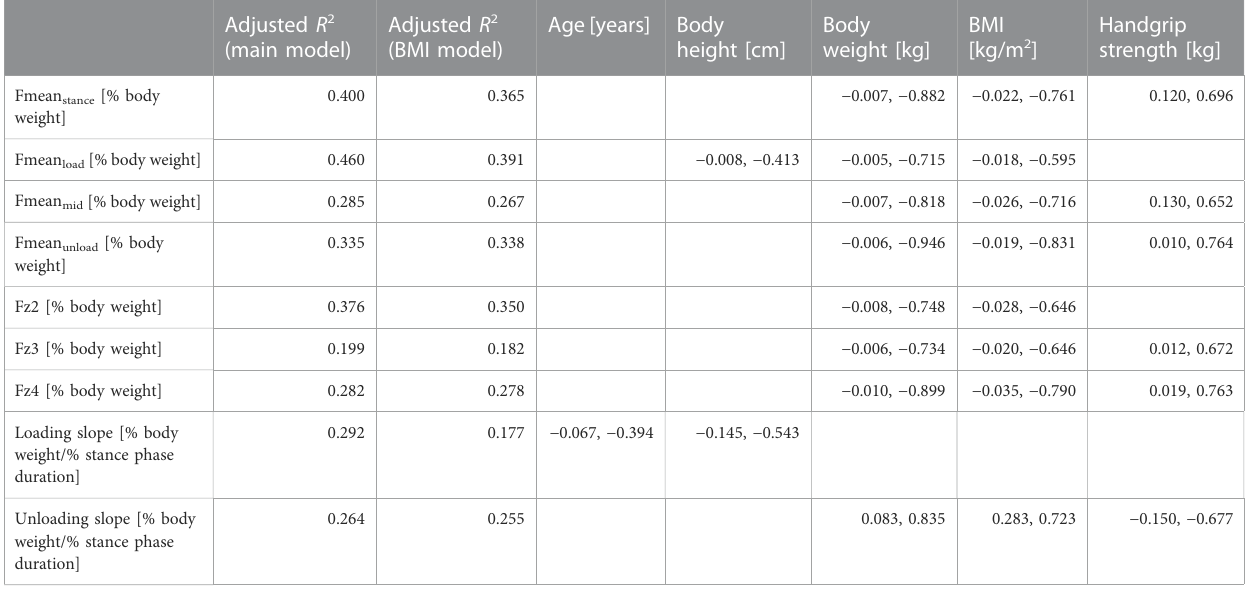
TABLE 3 Adjusted R 2 values of the main model that includes body weight and height, and of the model that includes BMI instead. In addition, non-standardized and standardized (Beta) coef fi cients of the computed parameters are shown, if signi fi cant, separated by a comma. The values shown for BMI are derived from the BMI model,the others from the main model. Units are either kg, cm, or years per percent body weight, or in case of slope kg, cm or years per percent body weight per percent stance phase duration. The non-standardized coef fi cients can be used to correct for age, height, weight, BMI and handgrip strength when analysing such